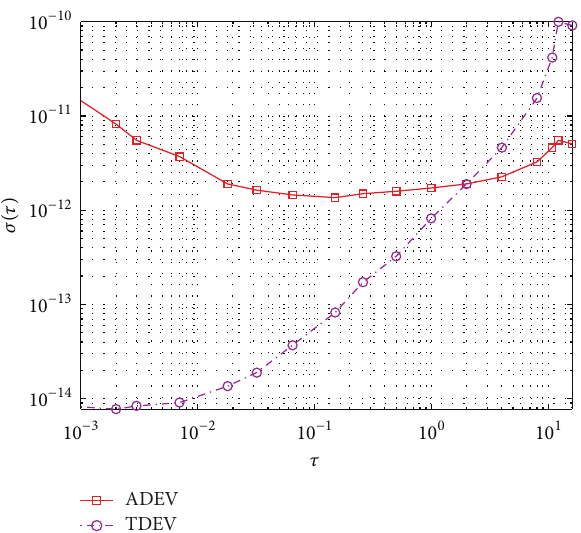
Figure 5: Comparative results of output phase noise between synchronization channel and radar channel.